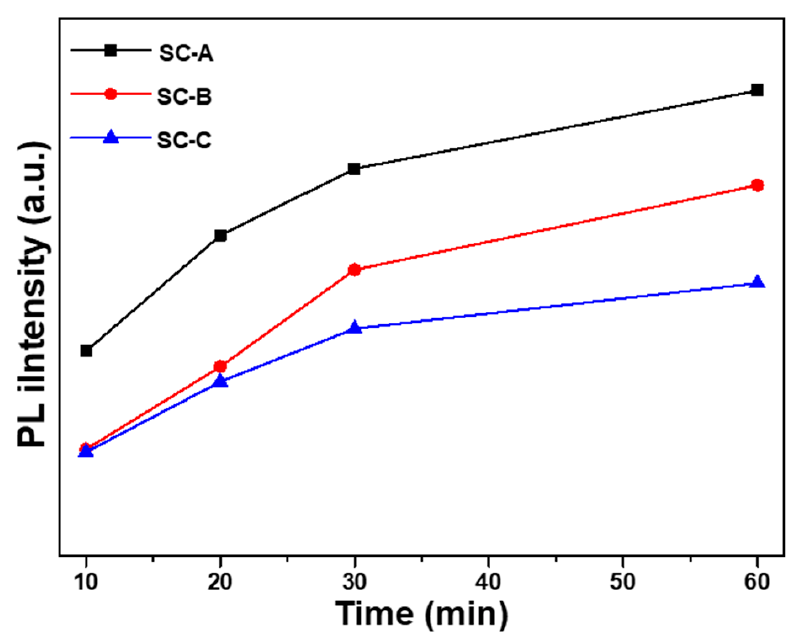
Figure 11. Emission intensities of I UV of the ZnO nanoflower arrays using different synthesis times and substrates.